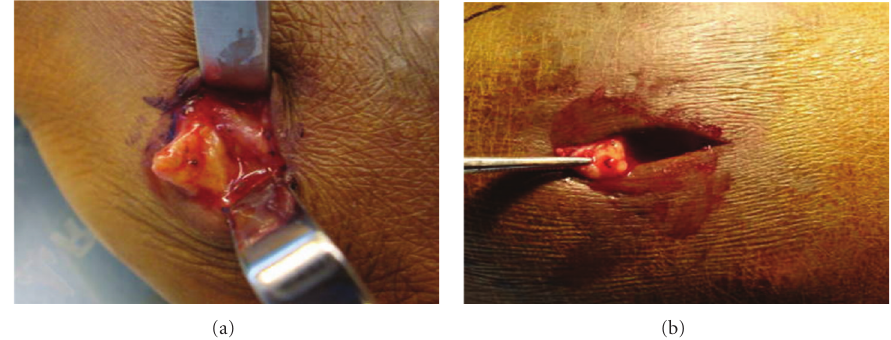
Figure 3: Intraoperative photographs of the right hand (a) and the right foot (b) demonstrating multiple black granules.